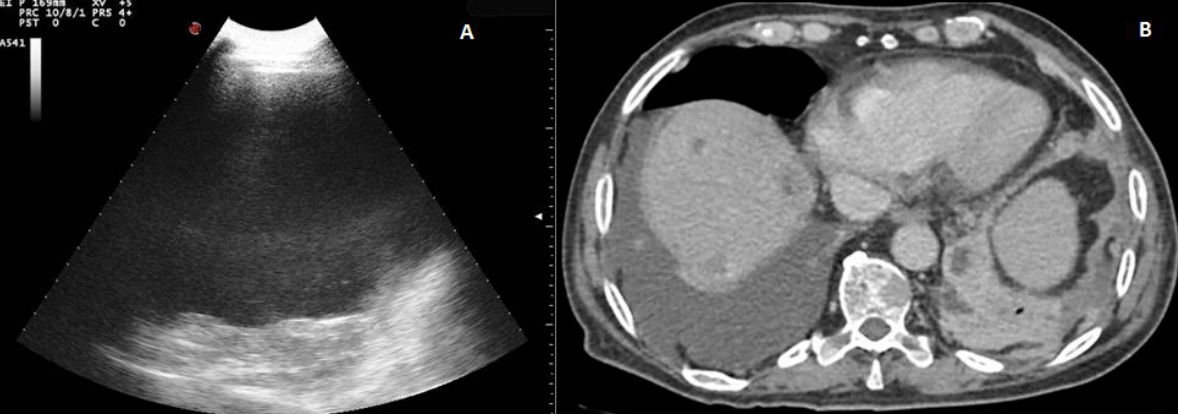
Figure 4. ( A ) TUS scan showing a homogeneous iperechoic pleural exudates viewed by a convex multifrequency probe (3.5 MHz). The drained fluid was macroscopically hemorrhagic. ( B ) The corresponding CT scan shows a large right effusion in a patient with a diagnosis of metastatic kidney cancer.